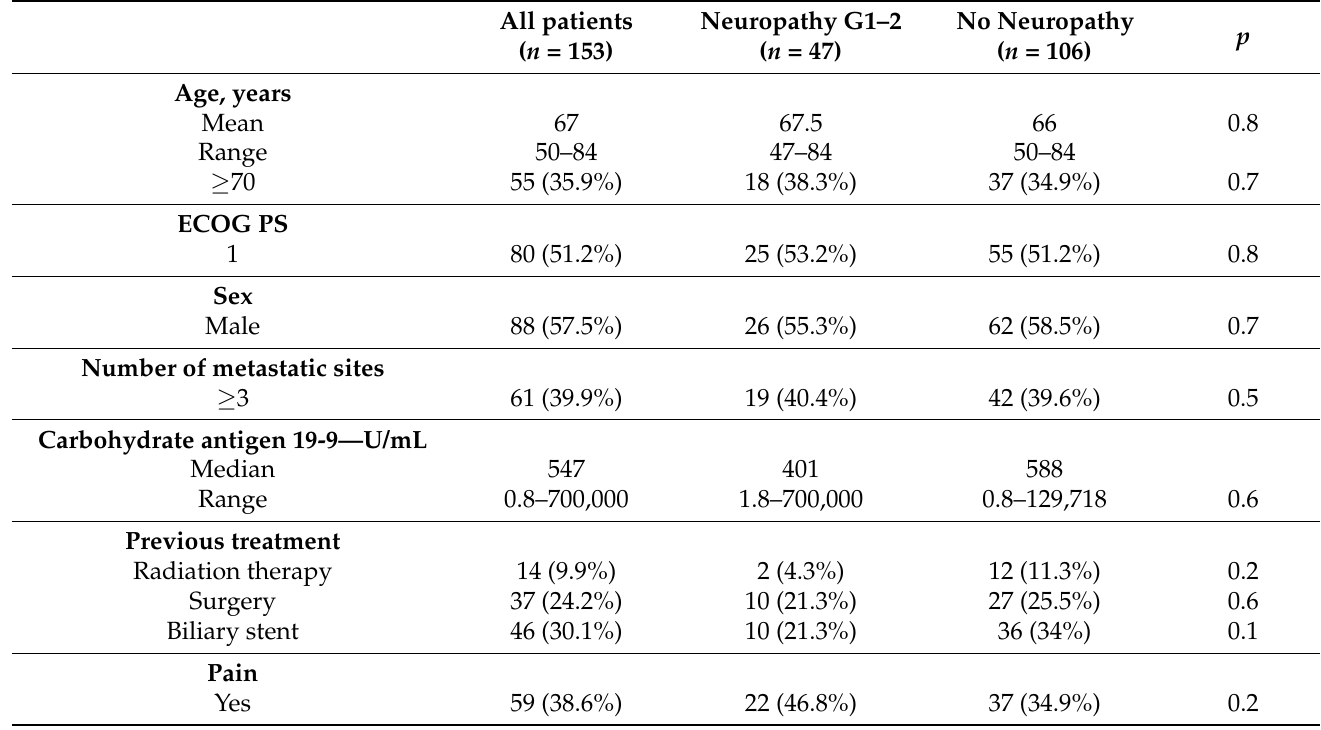
Table 1. Patient